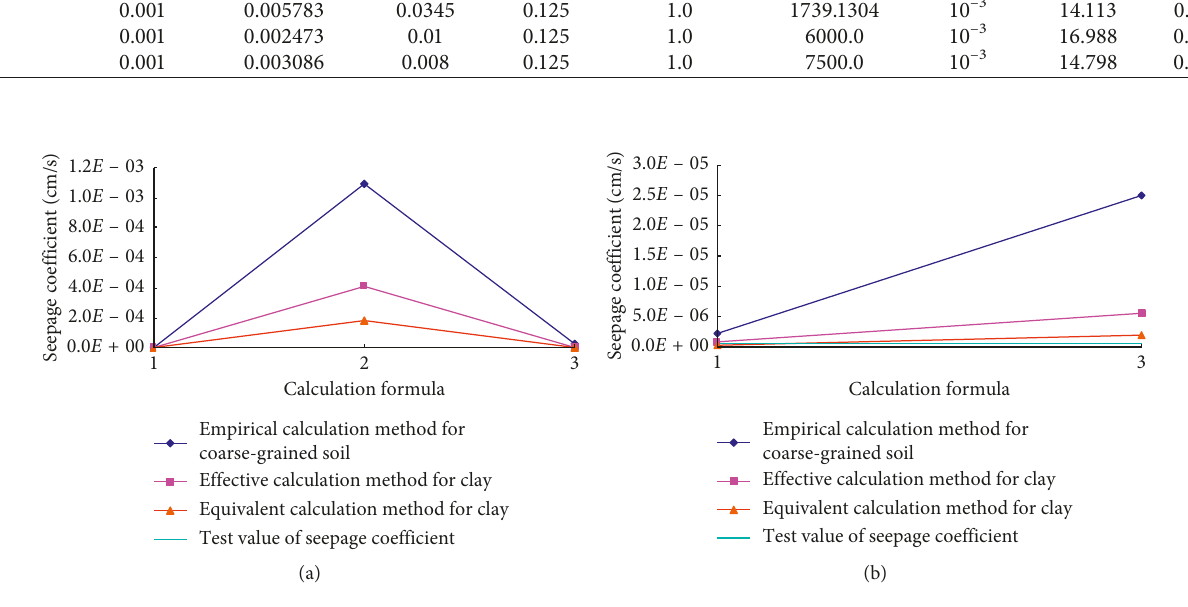
Figure 6: Seepage coefficients of compacted reconstruction loess under (a) formulas (1)–(3) and (b) formulas (1) and (3).